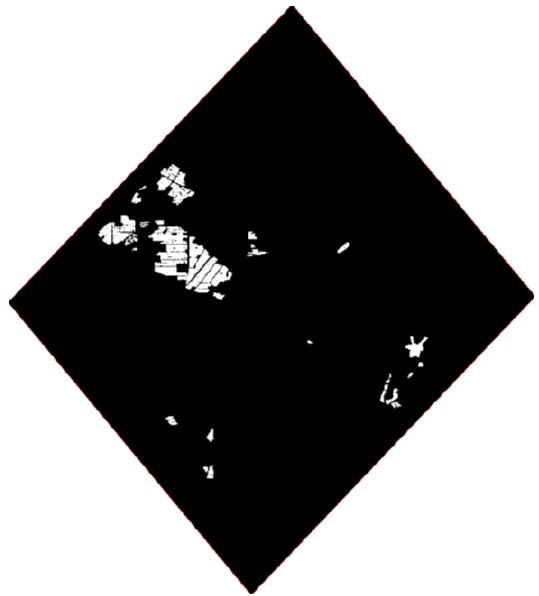
Figure 11: Target map of photovoltaic panels